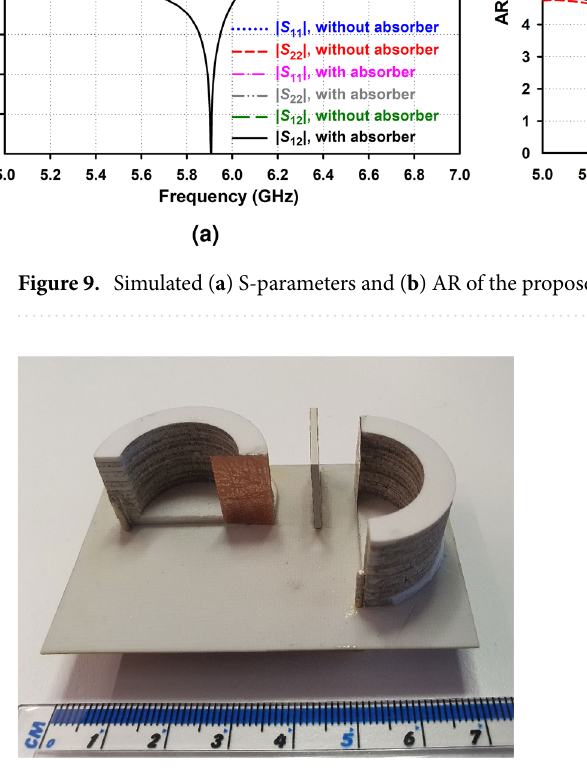
Figure 10. Implemented prototype of the proposed antenna.